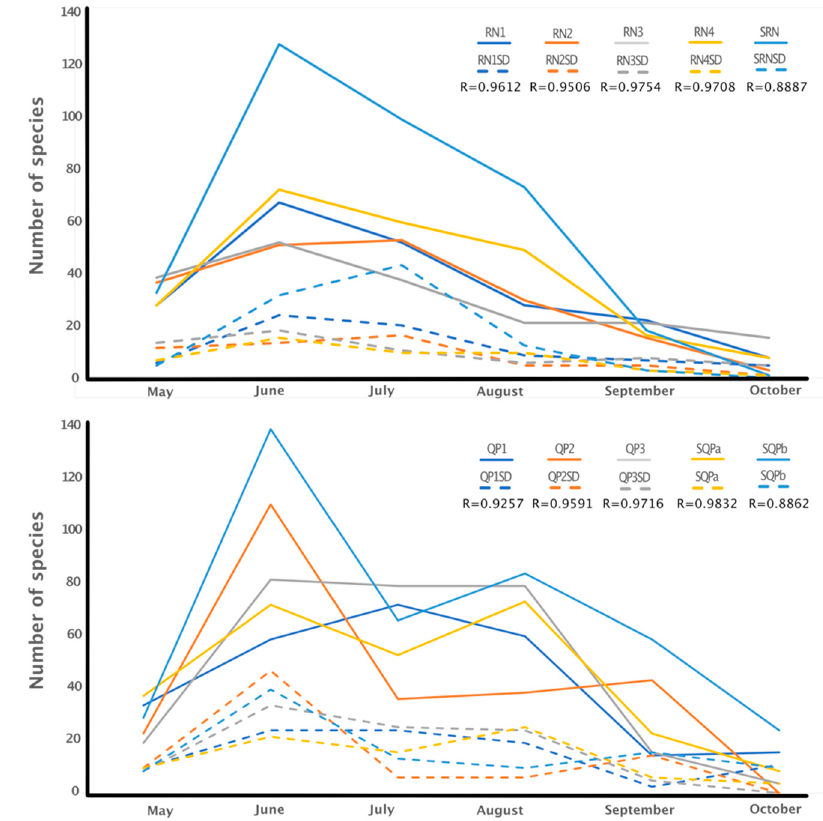
Figure 9. Total number of species collected (continuous lines) and SD species (dashed lines) collected per month in each site (NNP, Podlaskie, North-East Poland). The R value under each site represent the correlation between the total number of species collected per month in each forest site with the number of SD species collected per month in each site.